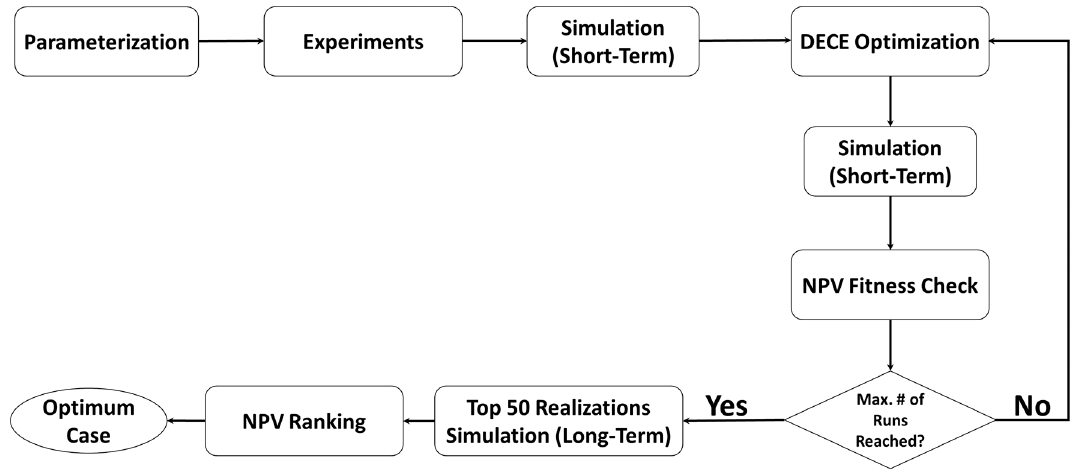
Figure 1. Outflow control devices’ (OCDs’) number of ports optimization process workflow.